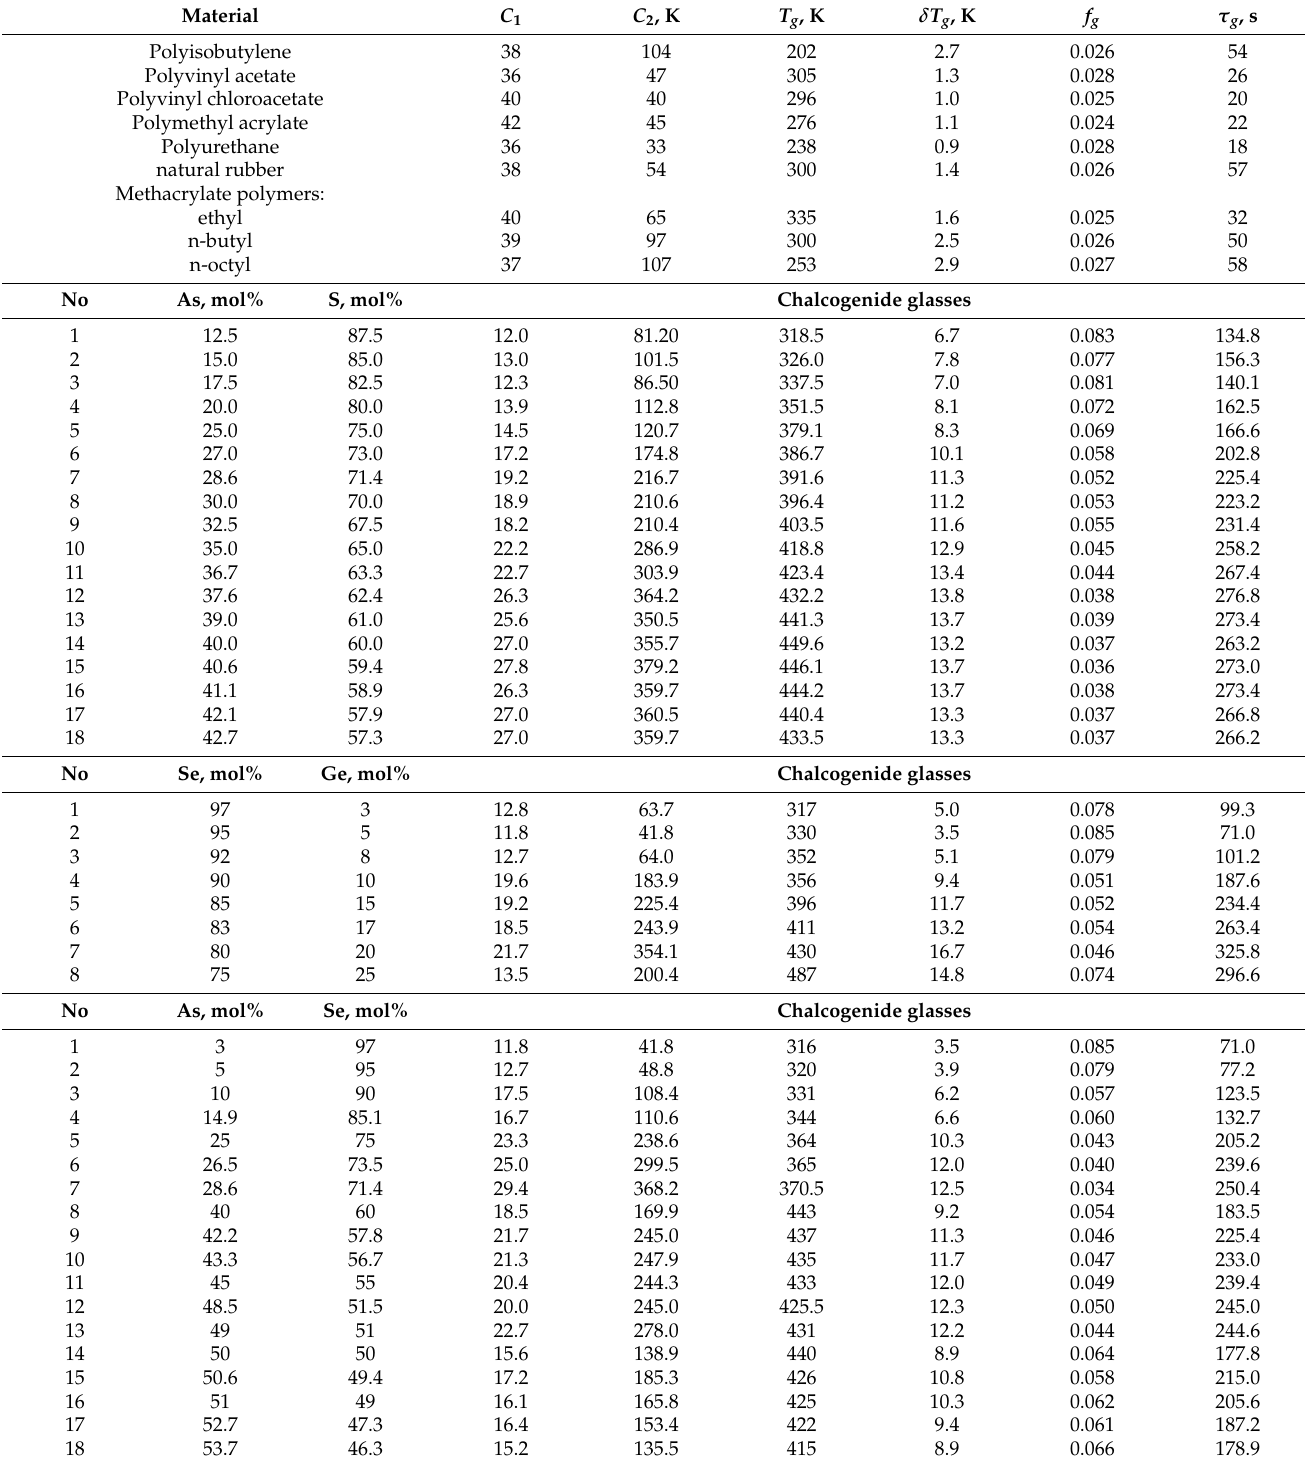
Table 1. The parameters of the WLF Equation (3) C 1 and C 2 and the characteristics of the glass transition process for polymers and glasses As-S, Se-Ge, and As-Se